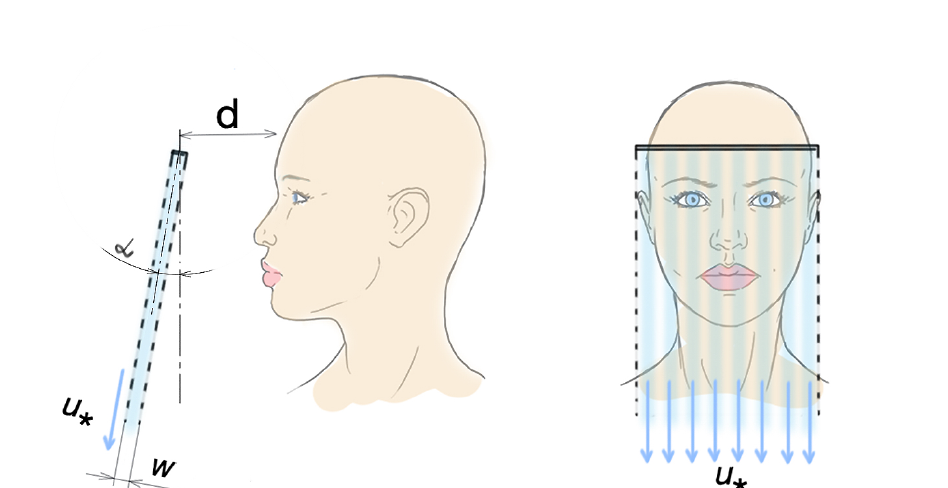
Figure 1. Schematic representation of the barrier of air curtain formed by narrow width, w , downward stream of velocity u ∗ , inclined at an angle α and localized at distance d from the plane of the protected